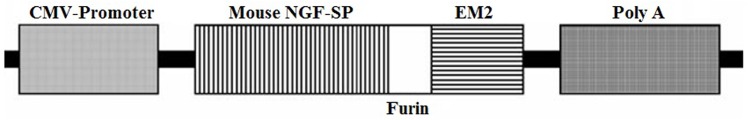
The fusion gene complex for endogenous endomorphin-2 (EM2) consisted of a gene for human EM2 and a gene for a signal peptide of mouse nerve growth factor (NGF).The fusion gene expression cassette was engineered under the control of a cytomegalovirus (CMV) promoter. The white area represented the cleavage site for Furin.